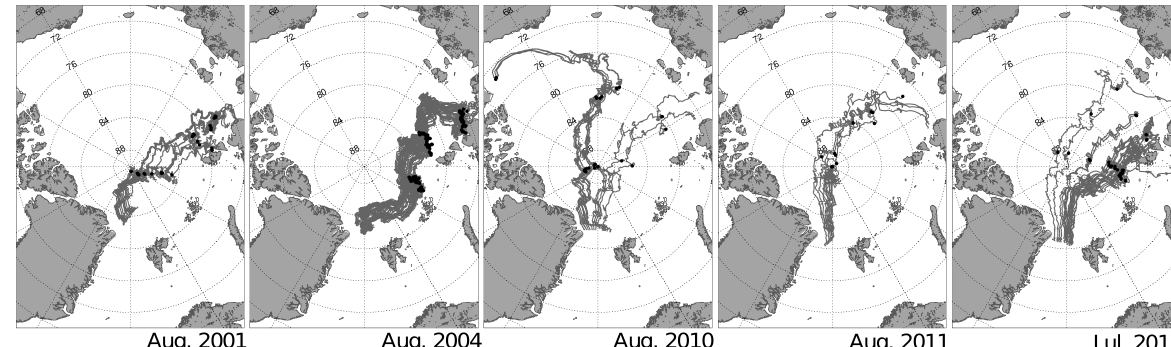
Figure 2. Backtracking of sampled sea ice using a combination of ice drift and concentration information. The start points of the trajectories (gray lines) are equivalent to the positions where EM measurements were obtained during the individual years. The black dots correspond to the position of particles on 21 September, when first-year ice becomes second-year ice, and second-year ice becomes multiyear ice.